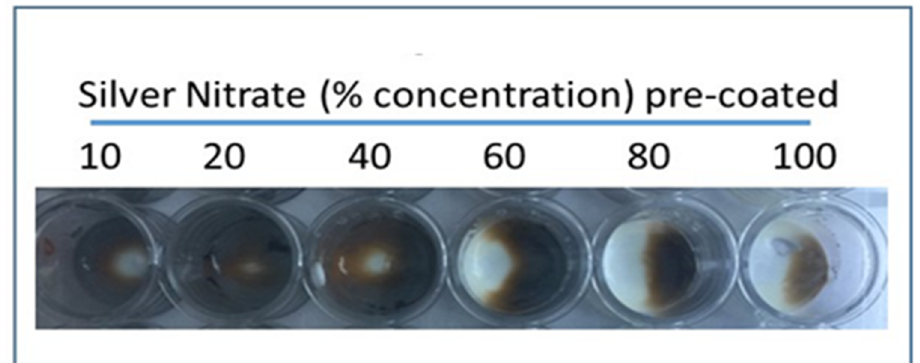
Figure 2. Reduction of silver nitrate solution of increasing concentrations by crystallized urate. Urate crystals were added to 200 µL solutions of increasing concentration of silver nitrate; 20% silver nitrate solution demonstrated most effective staining.